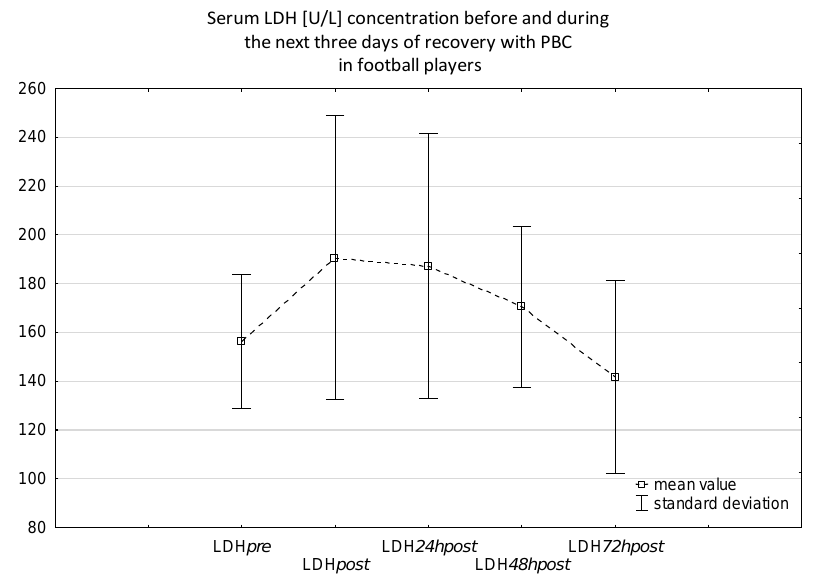
Figure 12. Lactate dehydrogenase concentrations before and after the match and in the course of post-exercise regeneration with the use of partial body cryostimulation.